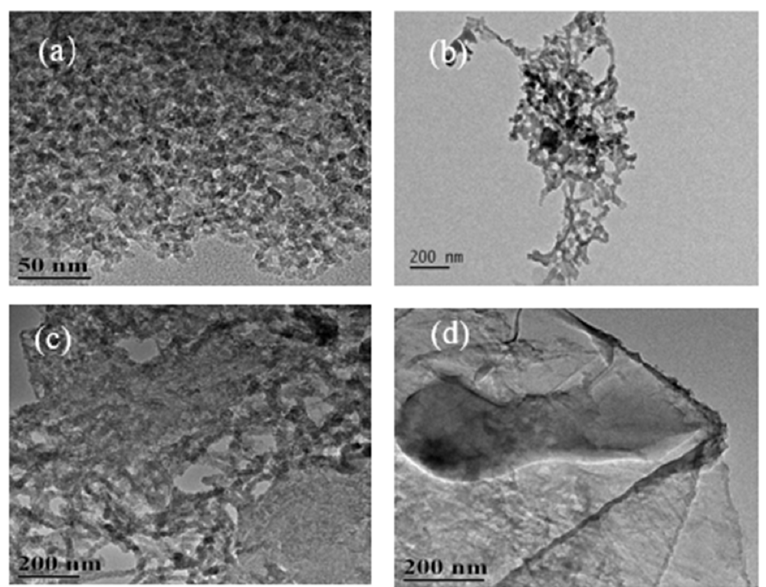
Figure 3. TEM images of carbon nanostructures at 500 °C: ( a ) 1CMC concentration carbon nanostructures; ( b ) 2CMC concentration carbon nanostructures; ( c ) 5CMC concentration carbon nanostructures; ( d ) 10CMC concentration carbon nanostructures.